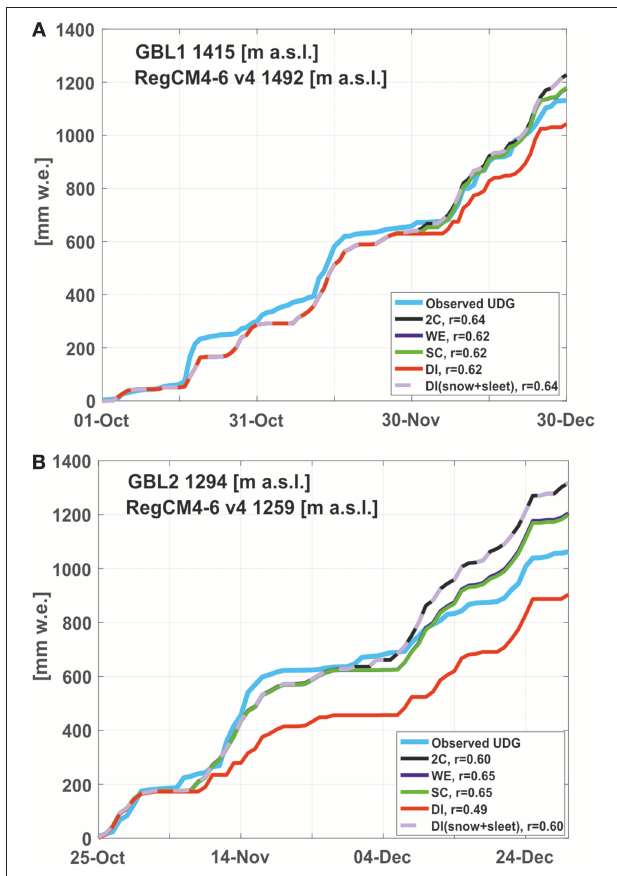
FIGURE 7 | Comparison of accumulated snowfall using four PPMs and observations at (A) GBL1 and (B) GBL2. The correlation coefficient (r) values of each method are calculated in comparing with the